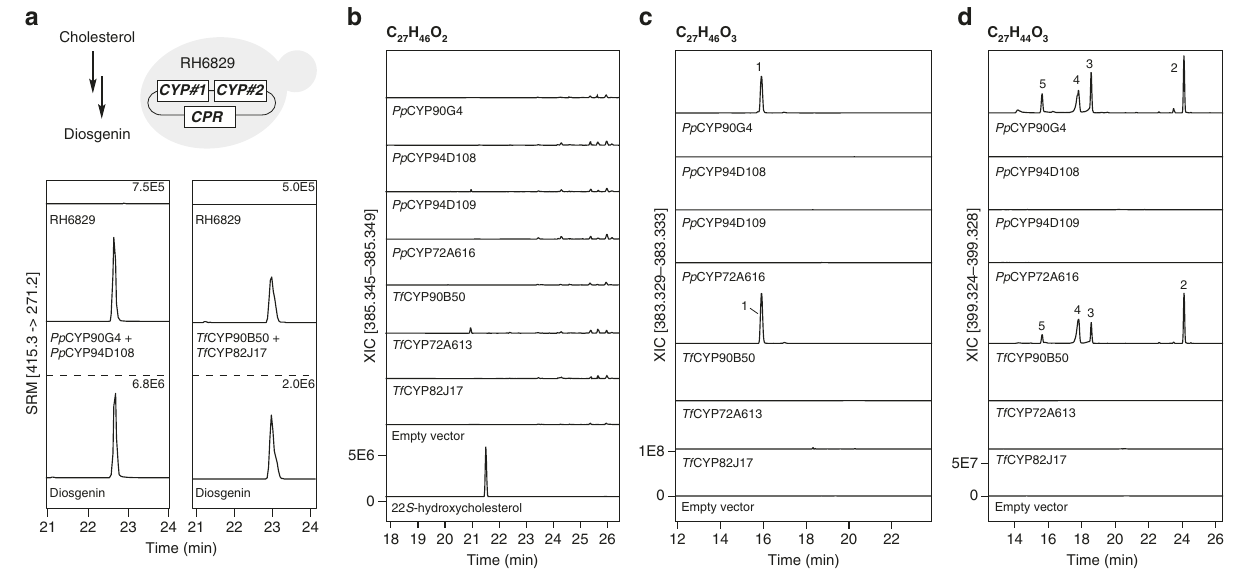
Fig. 2 Elucidation of CYP-mediated diosgenin biosynthesis from cholesterol. a Reconstitution of diosgenin biosynthesis in the yeast strain RH6829, which was engineered to accumulate cholesterol 25 . Co-expression of CYP pairs PpCYP90G4 / PpCYP94D108 or TfCYP90B50 / TfCYP82J17 together with a CYP reductase ( CPR ) from A. thaliana ( ATR1 ) led to diosgenin production in RH6829 yeast, shown in selected reaction monitoring chromatograms (SRM) from LC – MS data (peak intensity is indicated). b – d LC-HRMS-based metabolic pro fi ling of transgenic N. benthamiana expressing individual diosgenin- biosynthetic CYP s from P. polyphylla and T. foenum – graecum . Extracted ion chromatograms (XICs) corresponding to putative monohydroxylated cholesterol with predicted molecular formula of C 27 H 46 O 2 (identi fi ed as [M + H-H 2 O] + ions) b , and putative dihydroxylated-cholesterol derivatives C 27 H 46 O 3 (identi fi ed as [M + H-2H 2 O] + ) c and C 27 H 44 O 3 (identi fi ed as [M + H-H 2 O] + ions) d are displayed. Major products detected in N. benthamiana expressing PpCYP90G4 or TfCYP90B50 are labeled as compounds 1 – 5